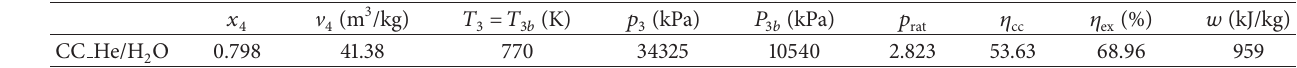
Table 9: The optimal parameters of the CC He-H